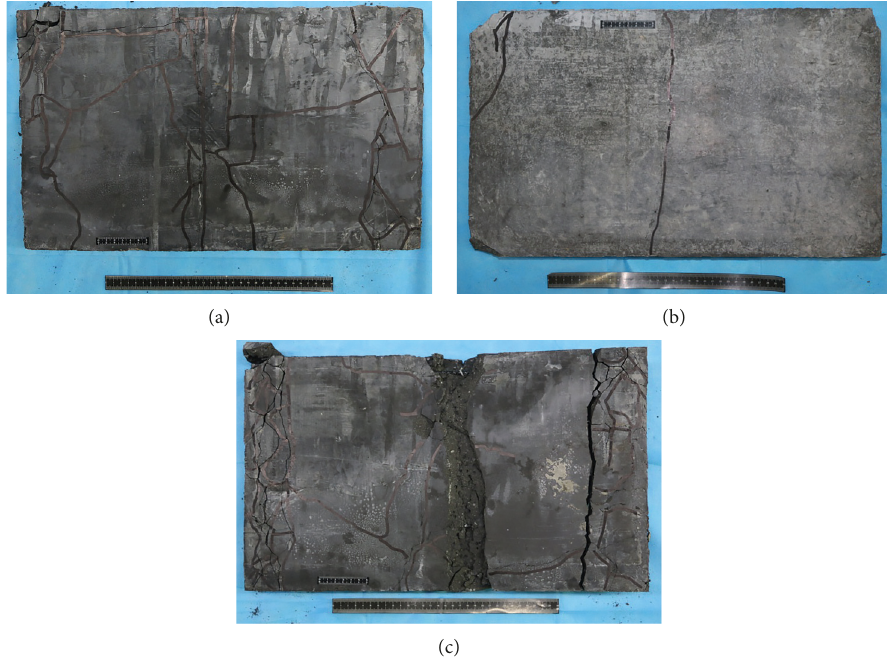
Figure 8: Cracks. (a) BS2-2. (b) SP2-2. (c)